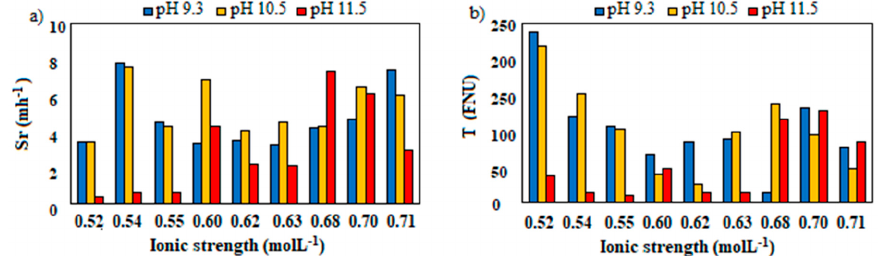
Figure 5. Mine tailings settling rate and turbidity as a function of the ionic strength at pH 9.3, 10.5, and 11.5. ( a ) Mine tailings settling rate and ( b ) turbidity as a function of Ionic strength at different pH